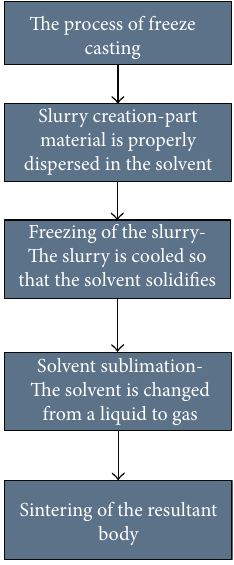
Figure 2: Process fl